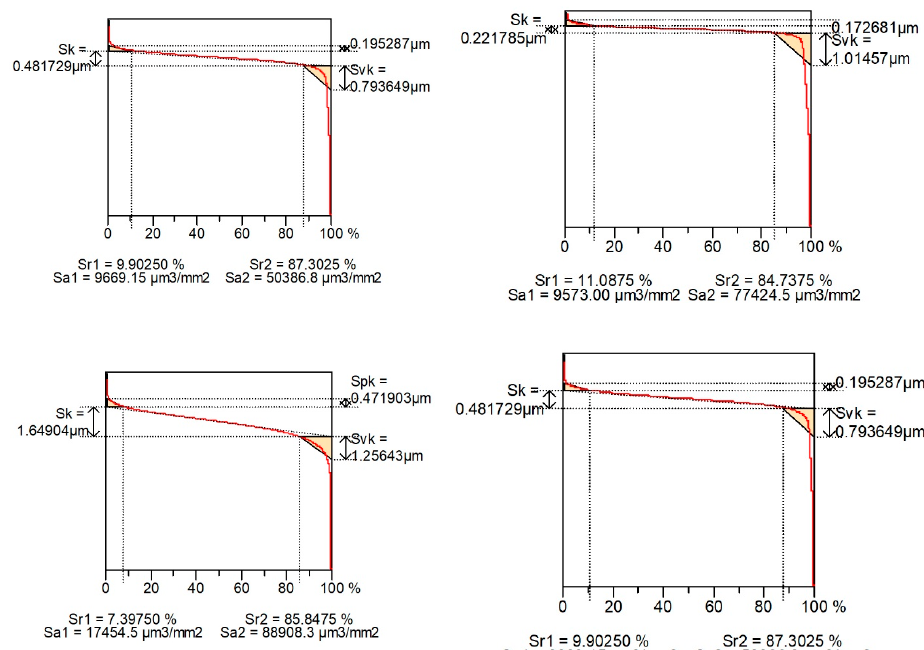
Figure 8. Material ratio curves of surfaces shown in Figure 7.